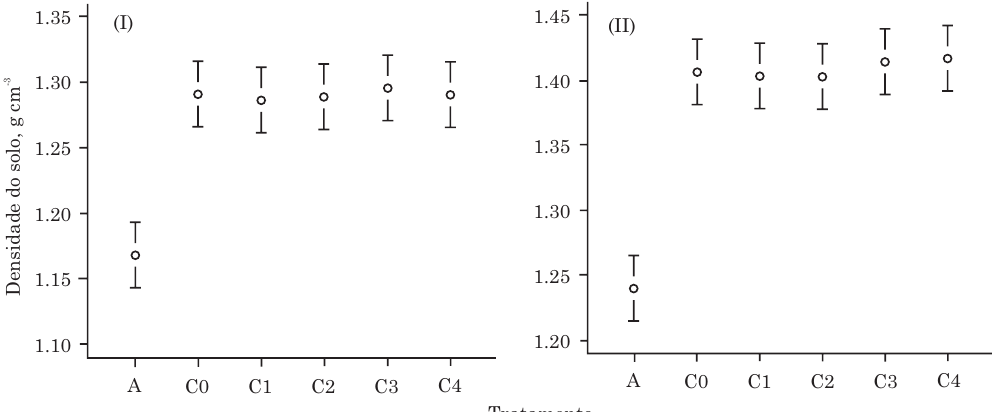
(1) Densidade do solo; (2) Conteúdo volumétrico de água do solo na capacidade de campo; (3) Porosidade total do solo; (4) Porosidade de aeração do solo; (5) Permeabilidade do solo ao ar; (6) DP: desvio-padrão; N=25.